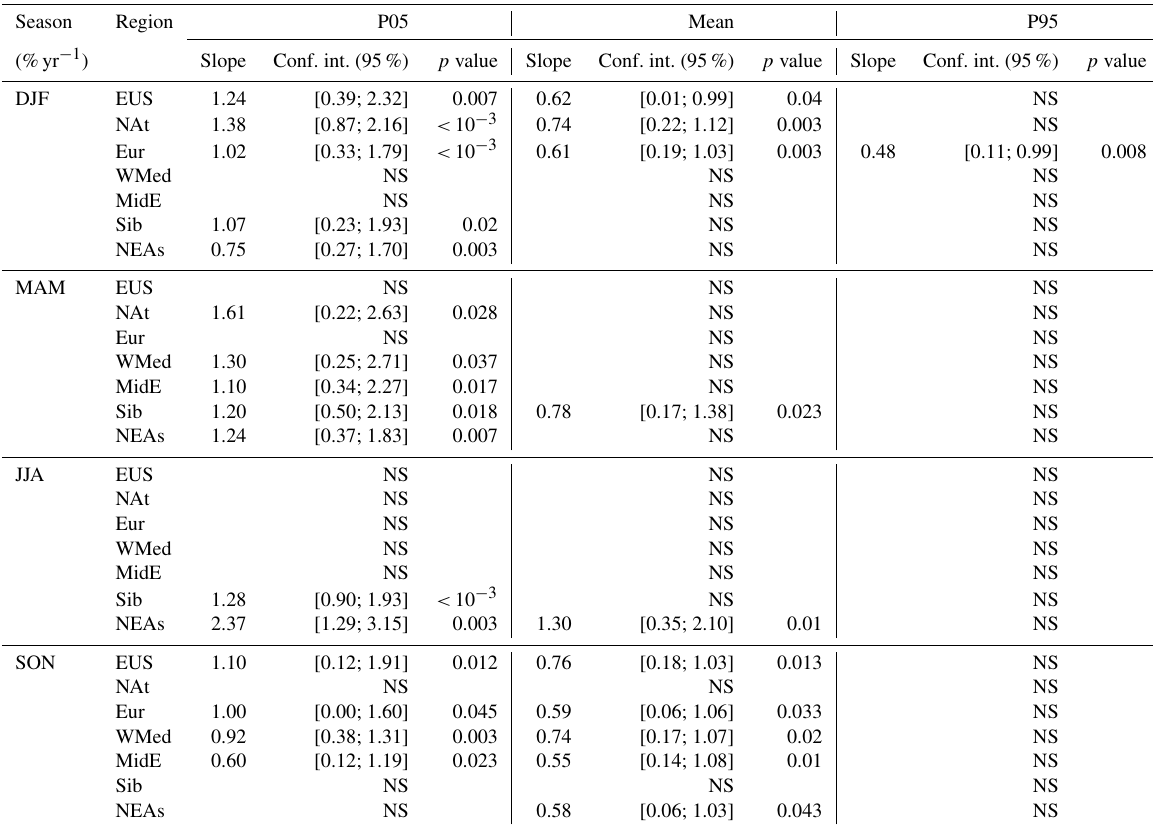
Table D4. O 3 relative trends in %yr − 1 during each season in the UT. From left to right, the anomalies are taken from deseasonalized P05, monthly means, and P95. The insignificant trends with respect to the 95% confidence level are indicated as NS.